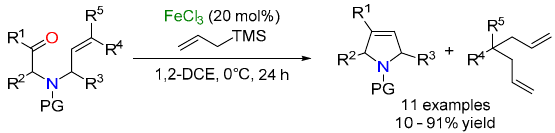
Scheme 14. General reaction equation of published reactions employing allyltrimethylsilane.